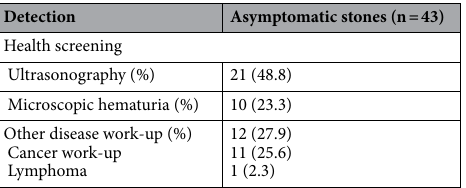
Table 1. Incidental diagnosis of silent stones.- ‘Health screening’ and ‘Other disease work-up’ are the same heading line, and ‘Cancer work-up’ and ‘Lymphoma’ are subcategories of ‘Other disease work-up’.